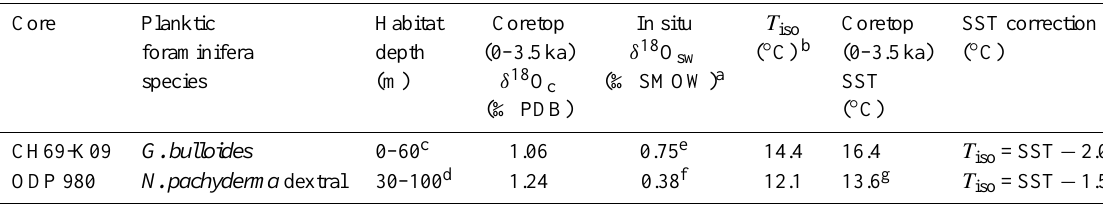
Table 2. Geochemical and hydrological parameters used to calculate the isotopic temperature ( T iso ) and the correction applied on SST from cores CH69-K09 and ODP 980 in order to reconstruct seawater δ 18 O ( δ 18 O sw )